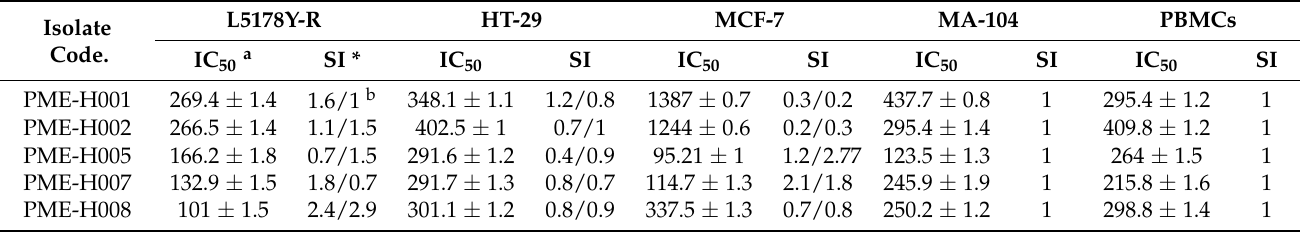
Table 2. IC 50 a and SI of tumor cell lines and MA-104 and PBMCs treated with fungus methanol extracts. Isolate Code.